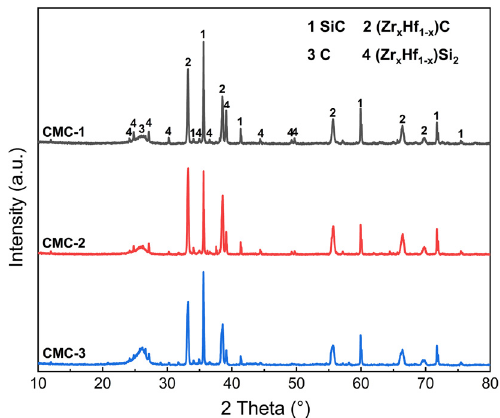
Figure 4. XRD patterns of the CMC composites prepared by RMI method.